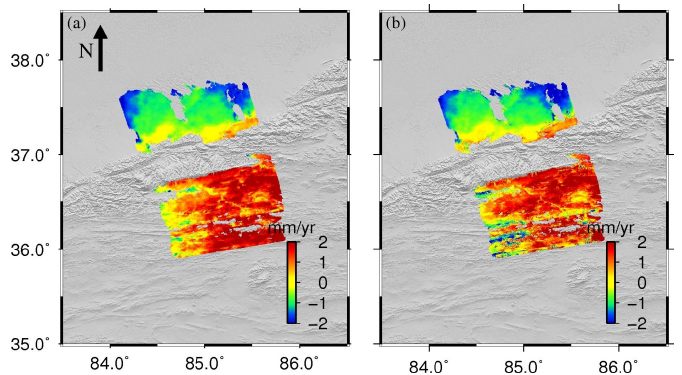
Figure 6. LOS velocity map of Ascending track 298 with ( a ) and without ( b ) the 10 October 2005